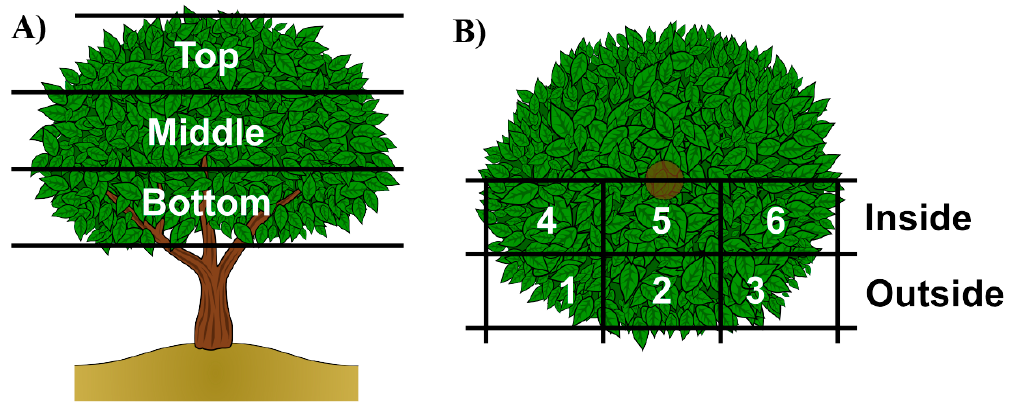
Figure 1. ( A ) Side view of a standard tree. Distribution of assessment zones in height; ( B ) Top view of a standard tree. Distribution of assessment zones at each